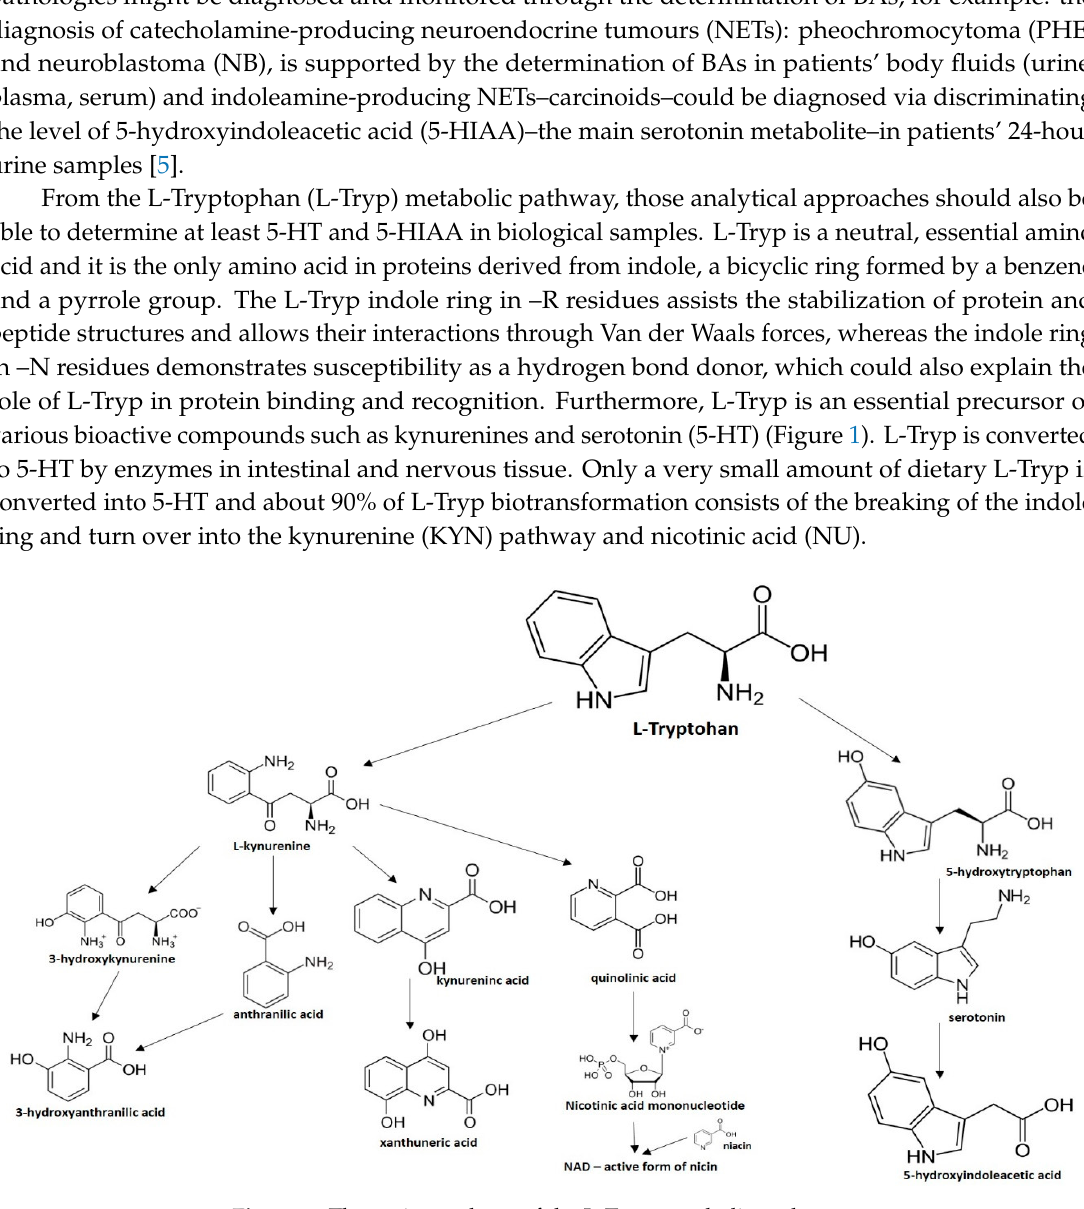
Figure 1. The main products of the L-Tryp metabolic pathway.